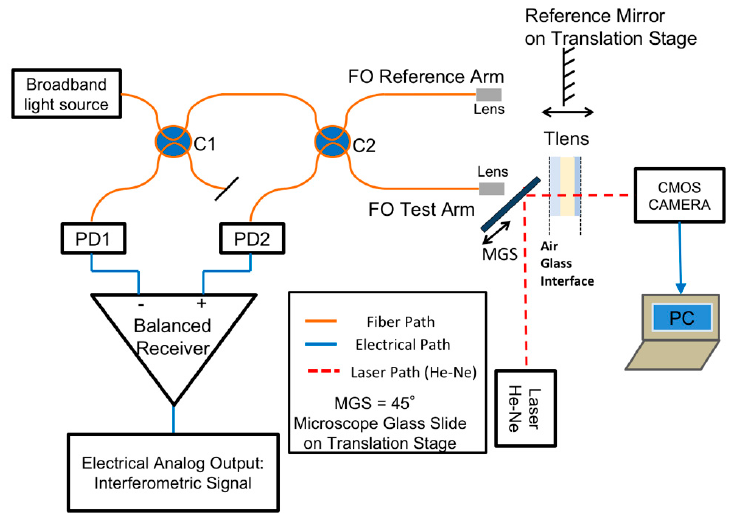
Figure 2. Reflectometric set-up. PD1, PD2: Photodiodes; C1, C2: 2 × 2, 50:50 fiberoptic coupler. FO—Fiberoptic path. MGS—Microscope Glass Slide on translation stage.